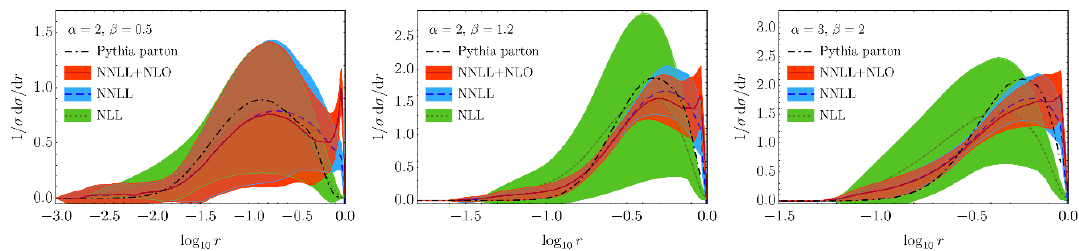
Figure 12 . The NLL, NNLL and NNLL+NLO cross section for the ratio of two angularities for ( (cid:11); (cid:12) ) = (2 ; 0 : 5) ; (2 ; 1 : 2) and (3 ; 2) (all normalized relative to the full NLO cross section), compared to parton-level predictions from Pythia